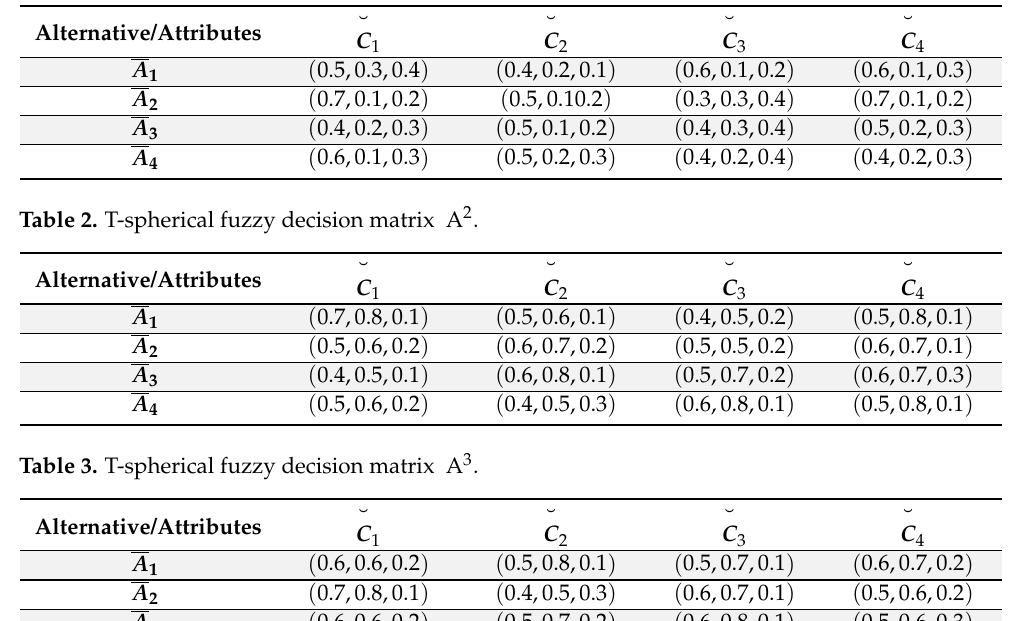
Table 1. T-spherical fuzzy decision matrix A 1 .